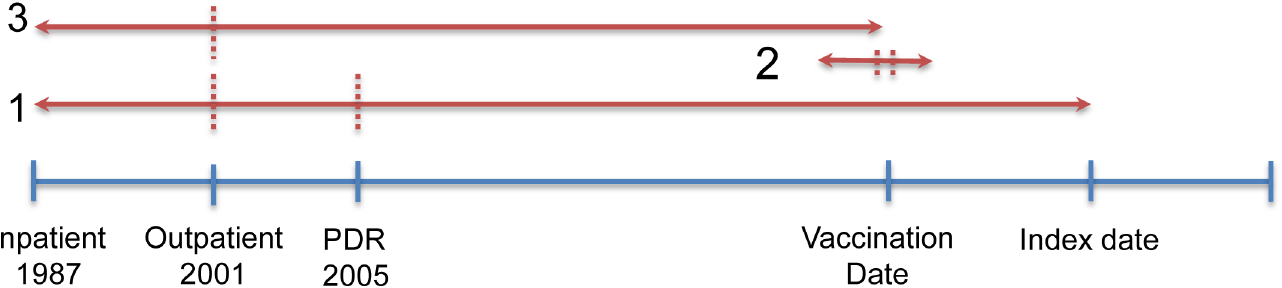
Fig 2. Exposure windows. 1. Prescription (ATC) and diagnosis (ICD10) history before index date (MSLT-referral date). Ever was defined as after the first date in either the inpatient register (1987), outpatient register (2001) or prescribed drug register (2005) and prior to the index date. 2. Prescription (ATC) and diagnosis (ICD10) history during the vaccination period. This period extended to six months before to one month after A(H1N1)pdm09 vaccination (specific to each individual). For acute infections (bacterial (ATC J01) and viral (ATC J05)) this period was shortened to two weeks before to two weeks after vaccination. 3. Prescription (ATC) and diagnosis (ICD10) history before vaccination. Ever was defined as after the first date in either the PDR (2005), inpatient register (1987) or outpatient register (2001) and prior to the vaccination